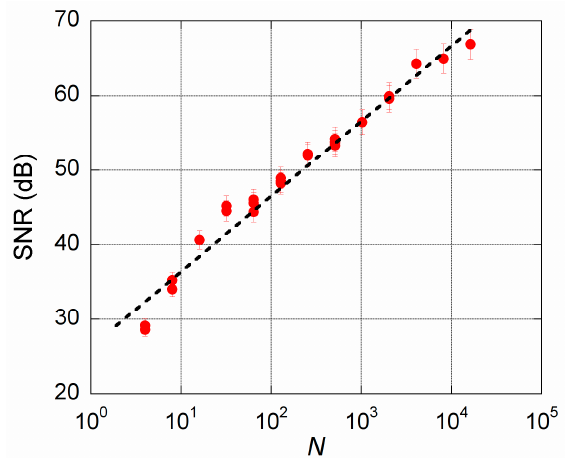
Figure 9. SNR of ADC output values as a function of gated integrated samples. The dotted line represents the expected SNR ~ N 1/2 behaviour.